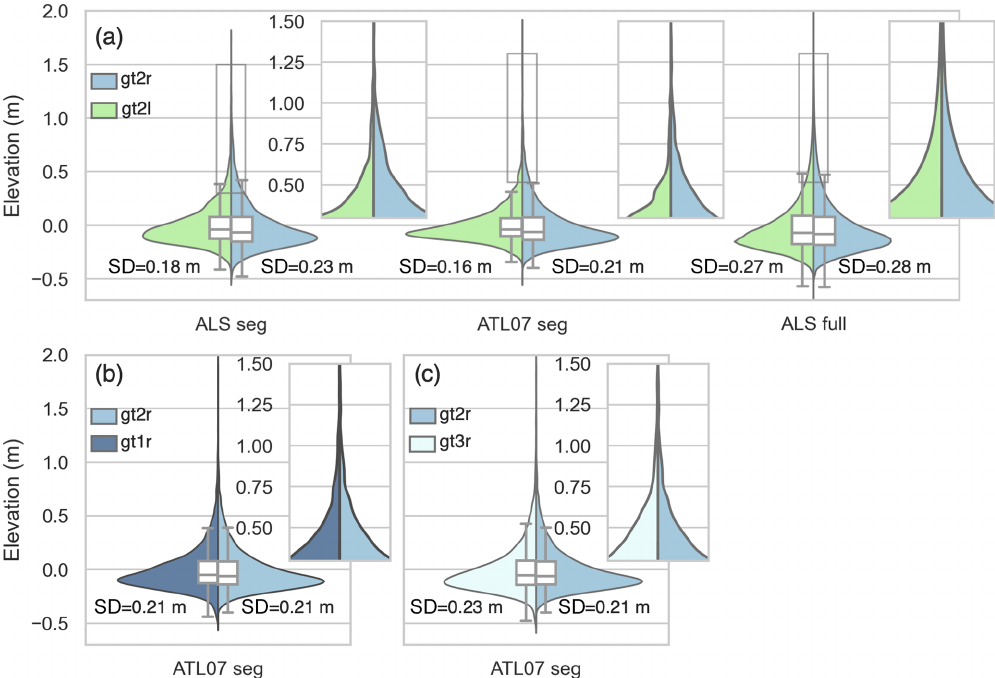
Figure 4. (a) Violin and box plots showing the elevation distributions from the segment-averaged ALS elevations (ALS seg), ATL07 segments (ATL07 seg), and the ALS elevations from all co-registered points at a 50cm resolution (ALS full), separated between weak (gt2l) and strong (gt2r) beam segments. (b) Violin and box plots showing the elevation distribution of the strong beams of beam pair 2 and 1. (c) Violin and box plots showing the elevation distribution of the strong beams of beam pair 2 and